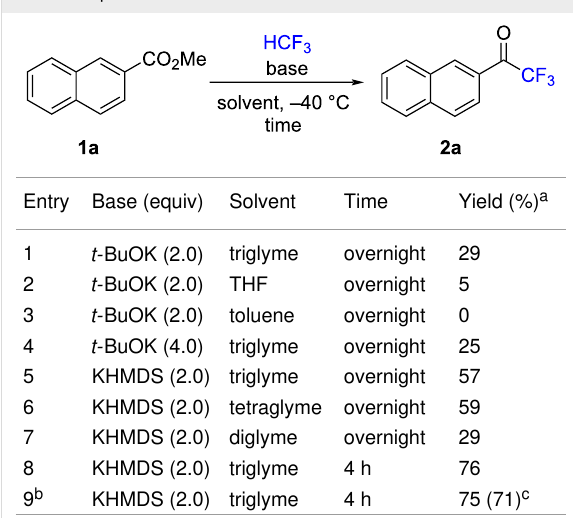
Table 1: Optimized reaction conditions for the conversion of 1a to 2a .